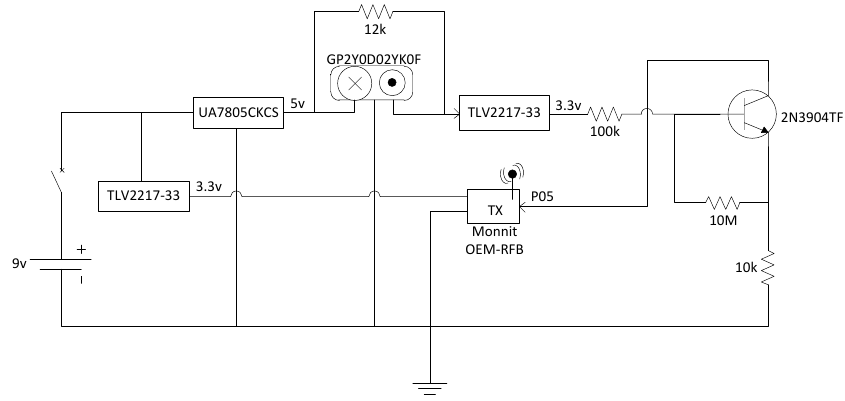
Circuit schematic of the internal component configuration of one wireless sensing